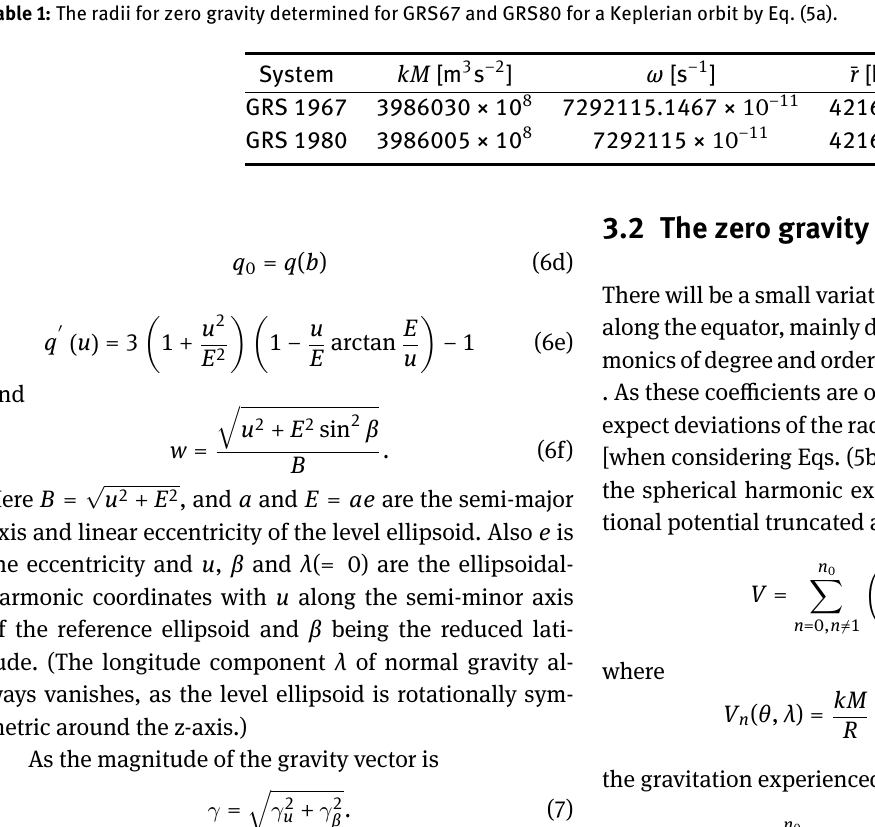
Table 1: The radii for zero gravity determined for GRS67 and GRS80 for a Keplerian orbit by Eq.